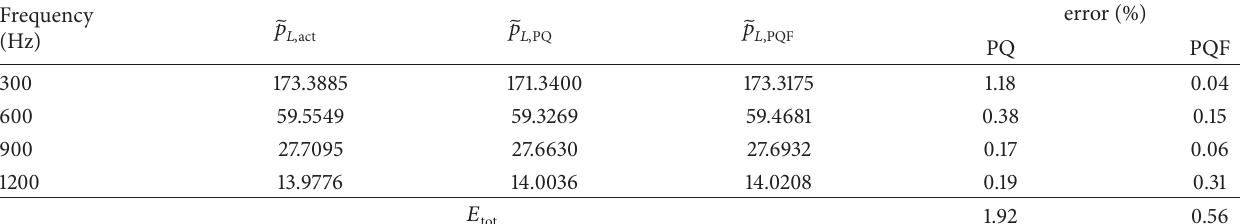
Table 2: The error of instantaneous active power for harmonic component